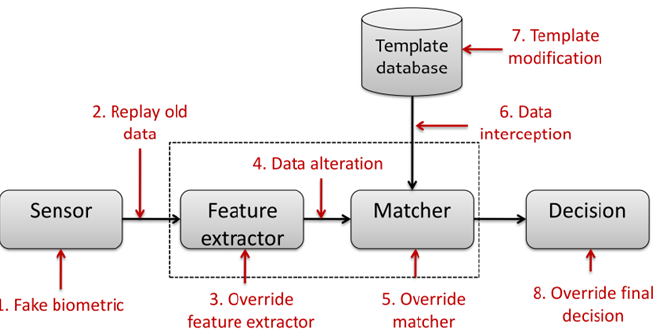
Figure 1. Locating vulnerabilities on a biometric system (defined by